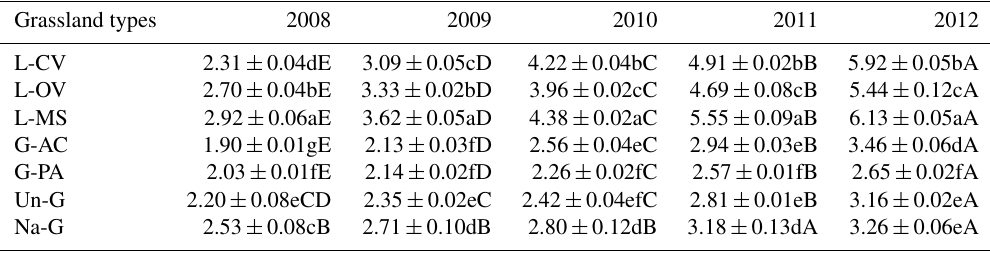
Table 4. Soil C concentration (M ± SEgkg − 1 , average value of 100cm soil depth) in different years and grassland types. The grassland types are L-CV, Coronilla varia ; L-OV, Onobrychis viciifolia ; L-MS, Medicago sativa ; G-PA, Poa pratensis ; G-AC, Agropyron cristatum ; Un-G, uncultivated grassland; Na-G, natural grassland. Values followed by different lowercase letters within columns and uppercase letters within rows are significantly different at p <0.05.